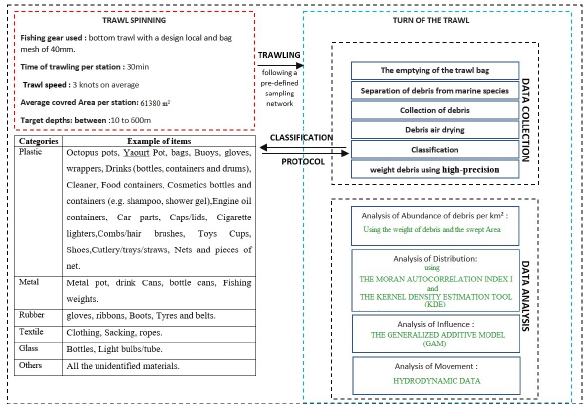
Figure 2. The methodoloy used to analyze the distribution of seafloor marine debris in Moroccan waters.